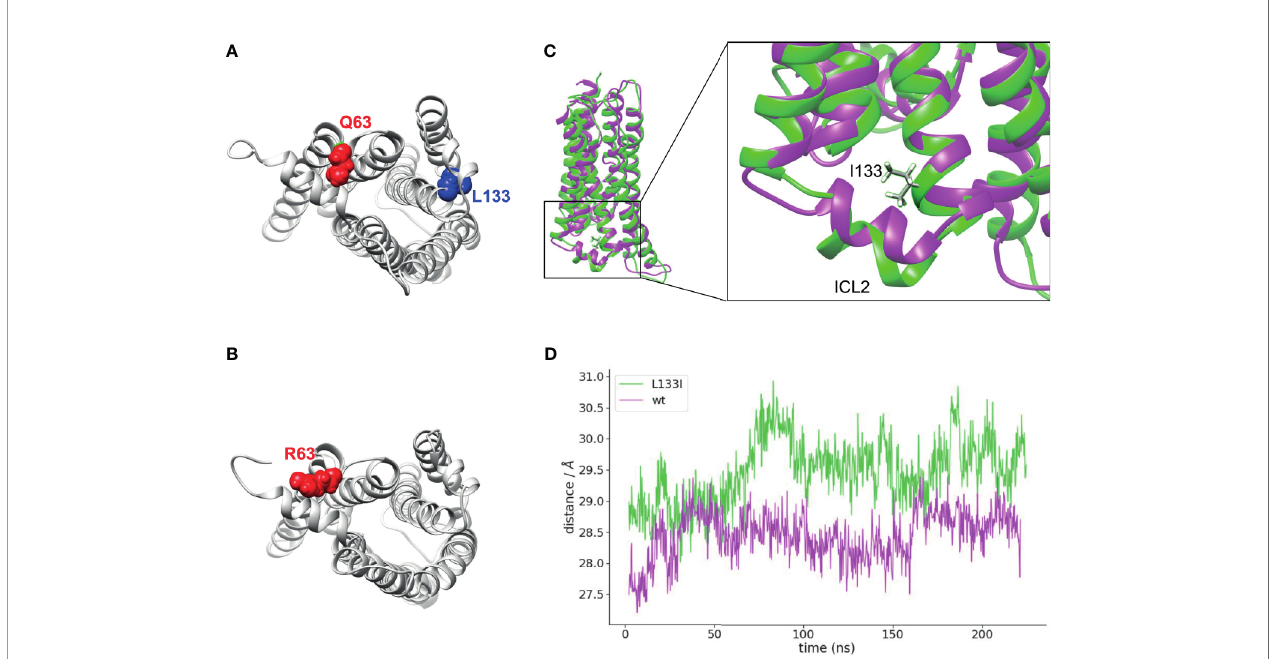
FIGURE 6 | Localizations of Q63 and L133 amino acids and molecular dynamics simulation: (A) Q63 (red) amino acid is located on the cytoplasmic surface of the CB 2 R, whereas L133 (blue) is located on the outer side of the TM3. CB 2 R receptor structure is shown from the cytoplasmic side. (B) R63 amino acid position on the